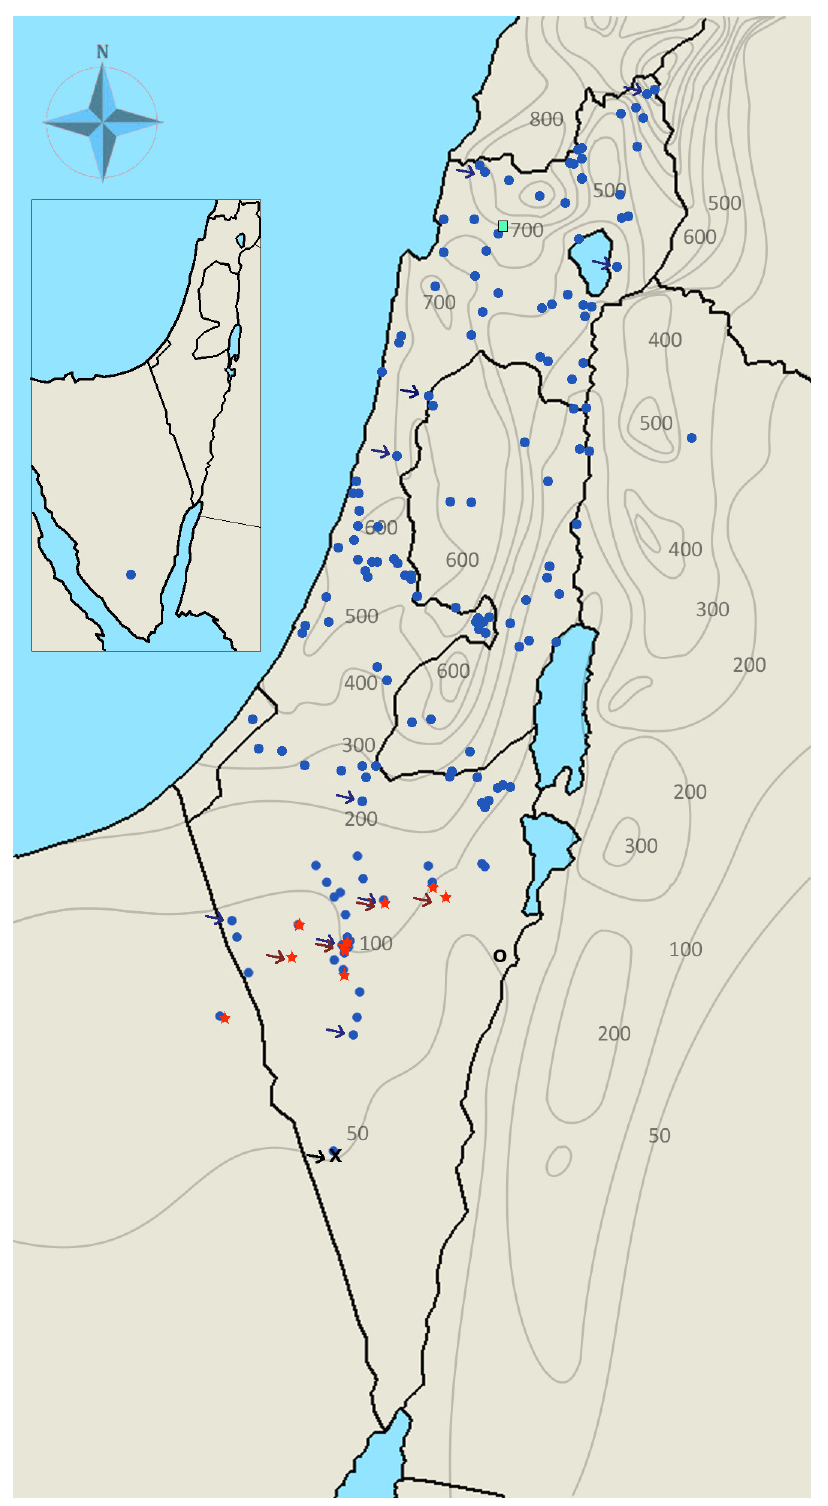
Fig. 1. Collecting localities for this study (small map points to a locality in southern Sinai). ■: Geolycosa vultuosa C.L. Koch, 1838. x : Lycosa gesserit sp. nov. o : Lycosa sp . ★ : Lycosa hyraculus sp. nov. ●: Lycosa piochardi Simon, 1876. Isohyets represent mean annual precipitation in mm. Arrows point to localities represented in molecular